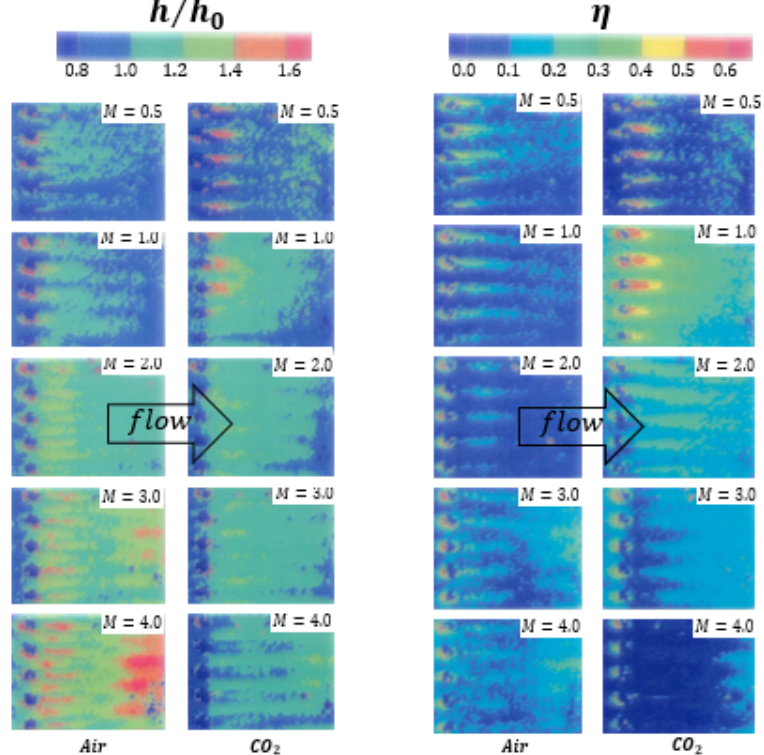
Figure 4. Detailed map of h and η obtained via two separate transient heat transfer experimental methodologies [21] (original figures contributed by the 1st author, Ekkad, S.V.).